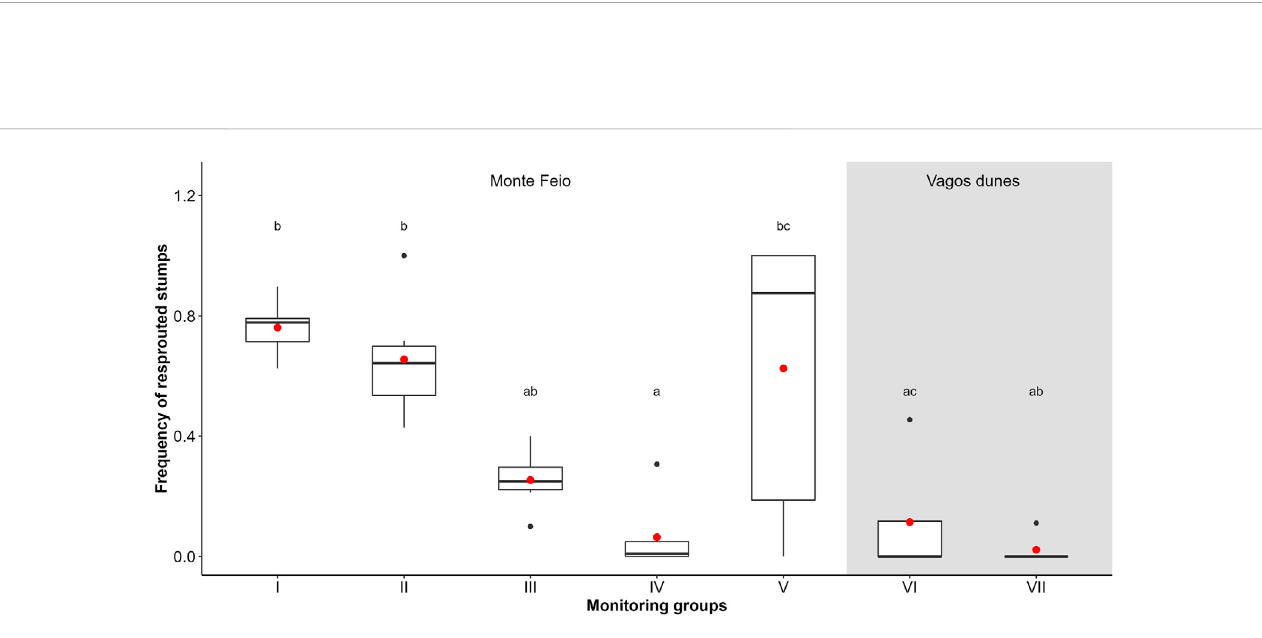
Frontiers in Environmental